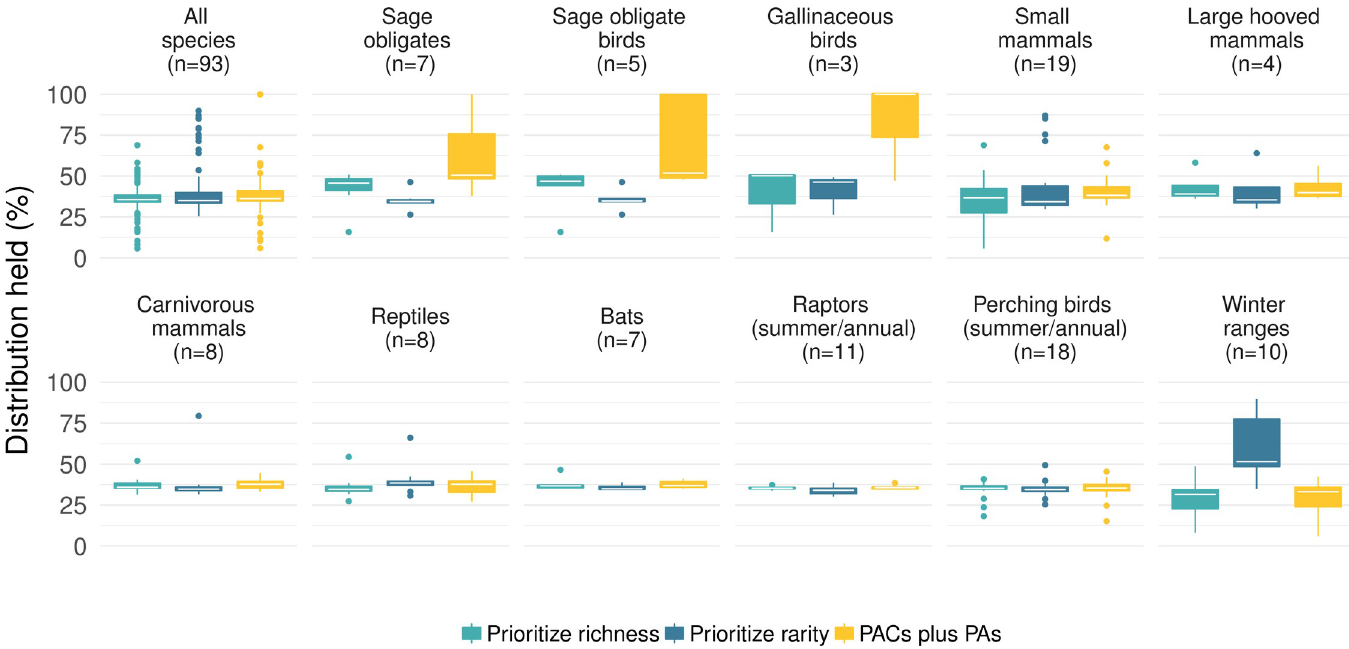
Fig 2. Comparison of the proportion of each species distribution (including sage grouse) currently held within Priority Areas for Sage Grouse Conservation (PACs plus PAs), and the proportion that could be held in an equivalent area prioritized across 81 sagebrush-associated species (91 species seasonal distributions, excluding greater and Gunnison’s sage grouse) under two objective functions ( Prioritize richness & Prioritize rarity ) using decision support tool Z ONATION . In all three scenarios we include the area already held in protected areas in the total for a species. The cross-species median coverage under each scenario is shown by a white line. The degree of overlap between these scenarios and PACs for the two sage grouse species was calculated after prioritization and these data points are included in this figure.